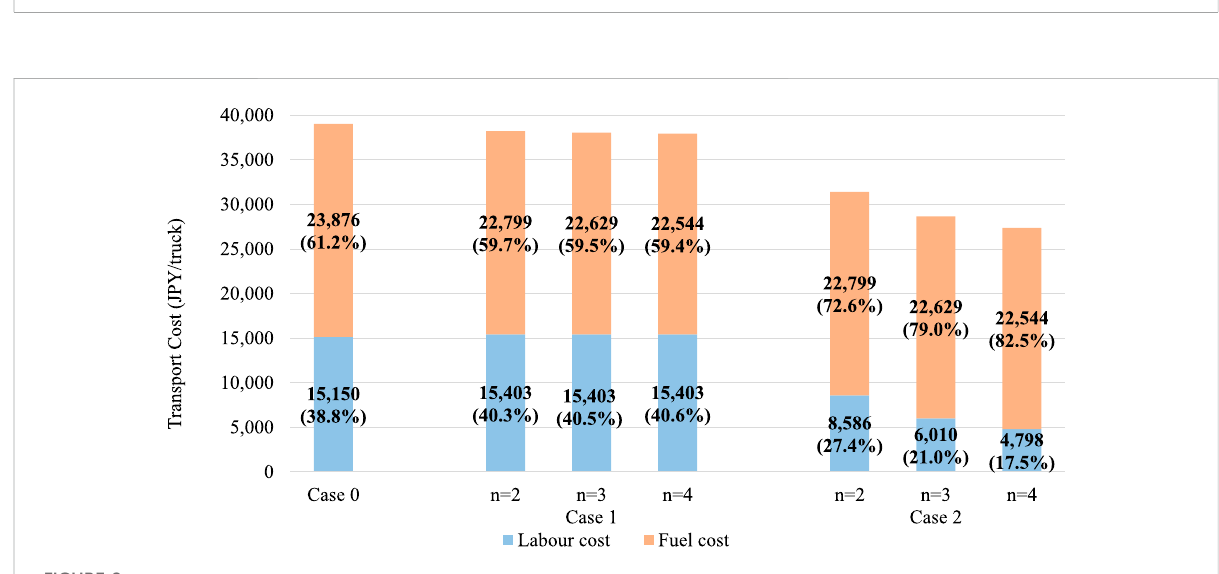
FIGURE 8 Breakdown of cost components for each inter-vehicle distance and operation case when s = 6, D = 800 and tf = 0.